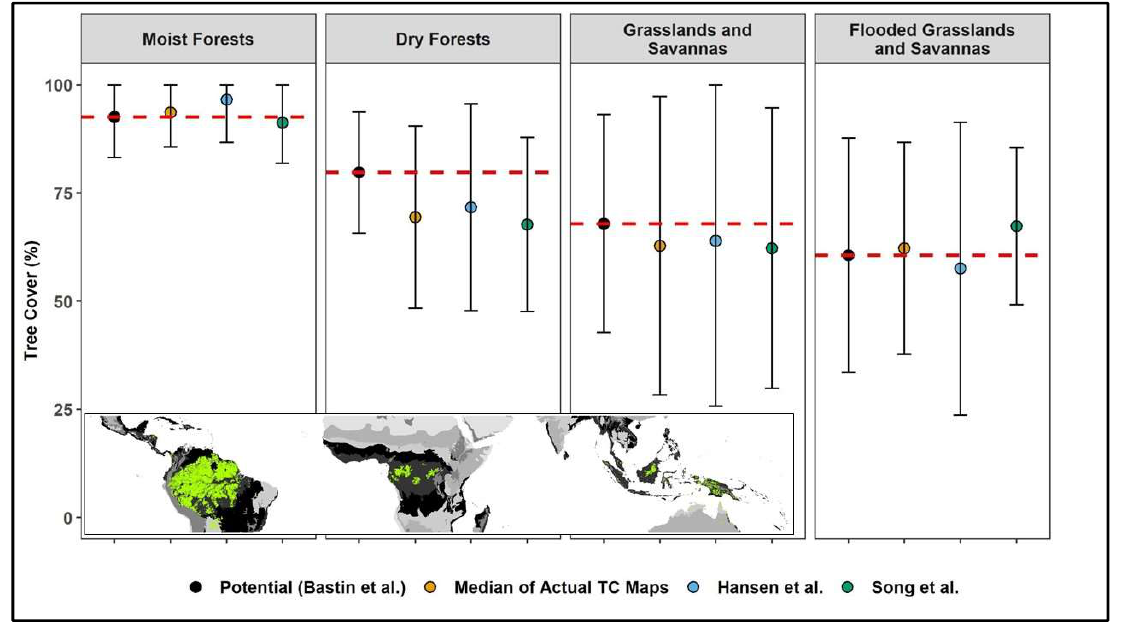
Figure 3. Potential and actual tree cover (TC) in wilderness areas in four tropical biomes. Dots indicate the mean of all individual pixels in a biome; whiskers refer to the standard deviation. The inset shows the location of wilderness areas (highlighted in green) within tropical biomes. We selected biomes where no. of pixels per biome in wilderness areas, n > 100. Here, Moist Forests, n = 54,755; Dry Forests, n = 1349; Grasslands and Savannas, n = 1016; Flooded Grasslands and Savannas, n = 227. Potential TC refers to Bastin et al. (2019), actual TC maps are taken from Hansen et al. (2013) and Song et al. (2018). ‘Median of actual TC maps’ refers to the pixel-level median of the two actual TC maps. For information on how wilderness areas were delineated, see Materials and Methods Section.